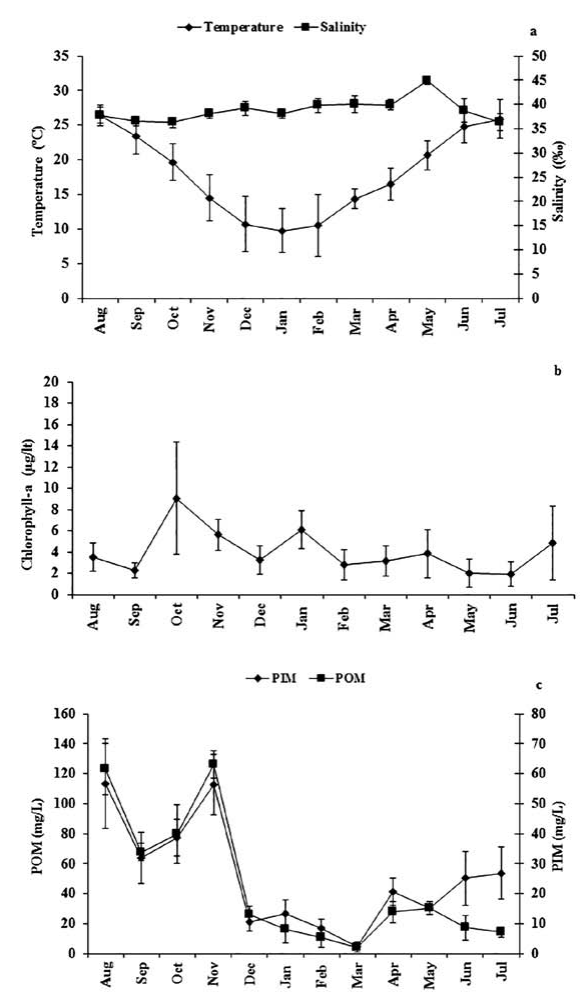
Fig. 2. – Mean monthly variation of seawater temperature (a), salin- ity (b), chlorophyll a (b), particulate inorganic matter (PIM) (c) and particulate organic matter (POM) (c) in Homa Lagoon from August 2008 to July 2009.